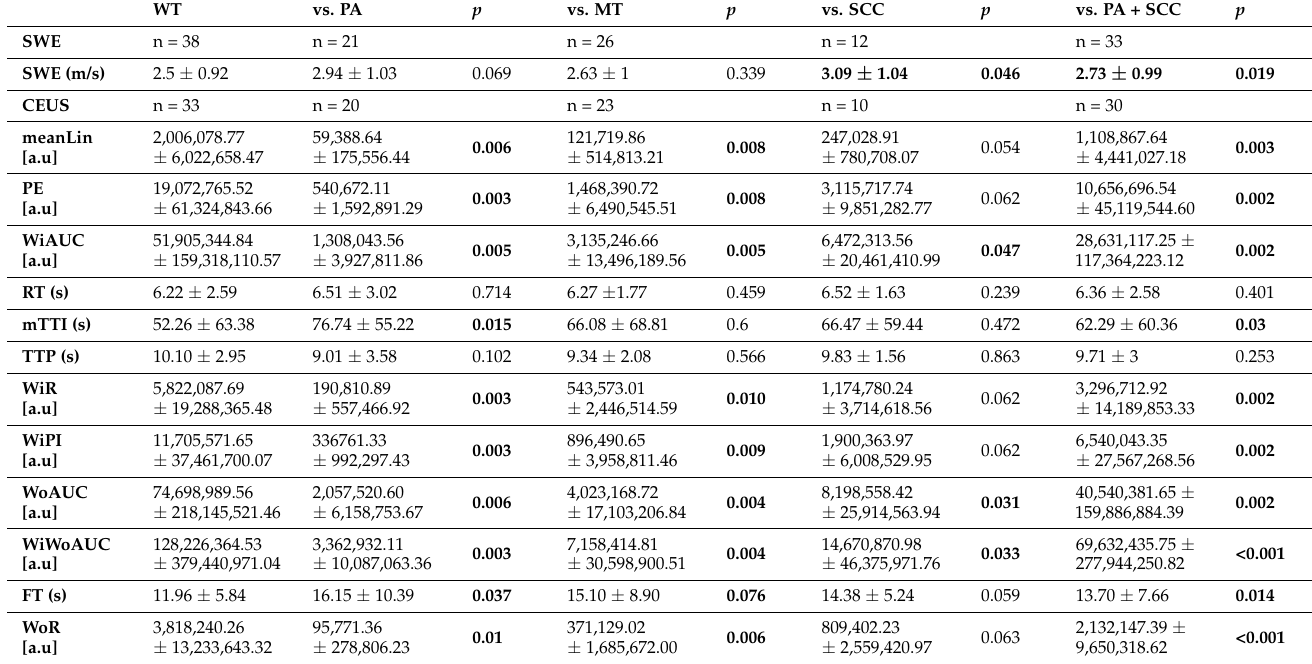
Table 3. Results of Warthin’s tumor compared to different entities. All metric variables are given as the median with corresponding standard deviation; significant p -values are pointed out in bold.